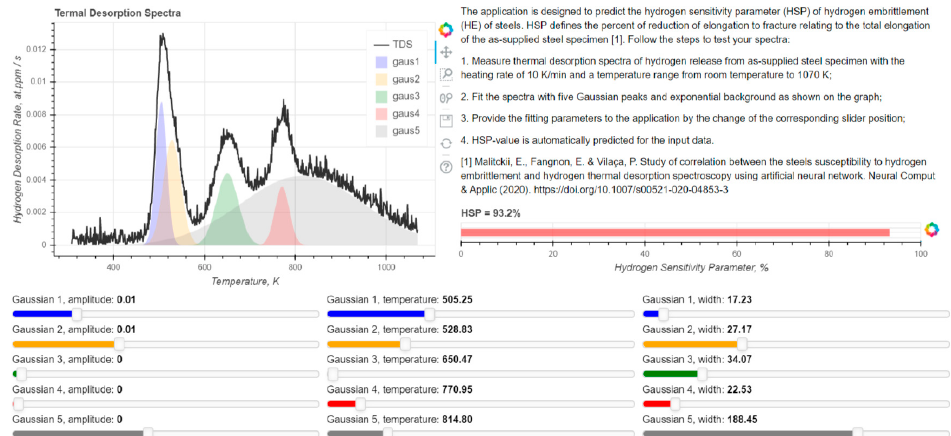
Figure 9. Prototype interactive application predicting the HSP using the developed ANN model. Parameters of the spectra can be adjusted using sliders. The value of the HSP changes on-line with the change of the input parameters of the TDS spectra. The developed model was deployed and it is openly available online [33].